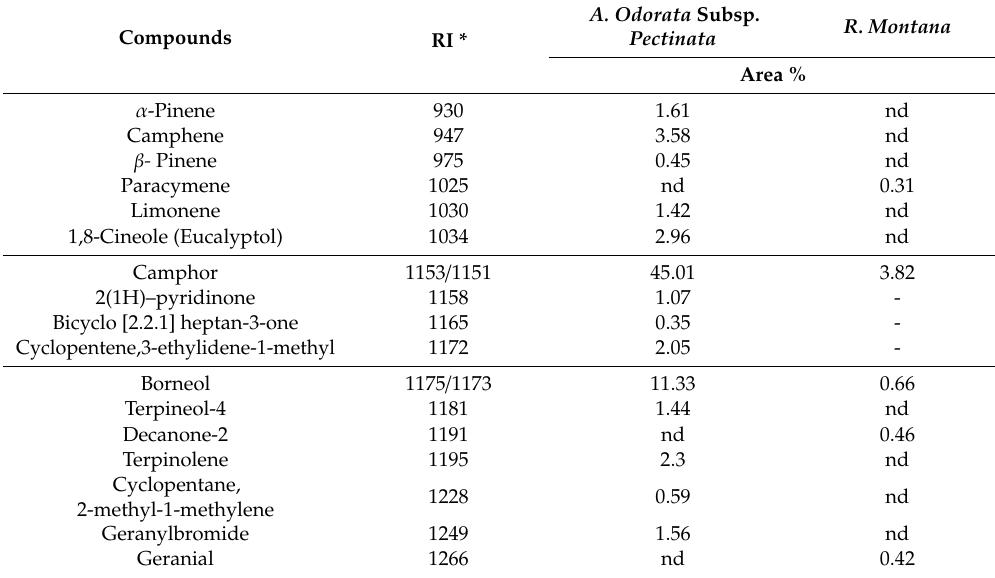
Table 1. Chemical composition of essential oils obtained from A. odorata subsp. pectinata and R. montana.